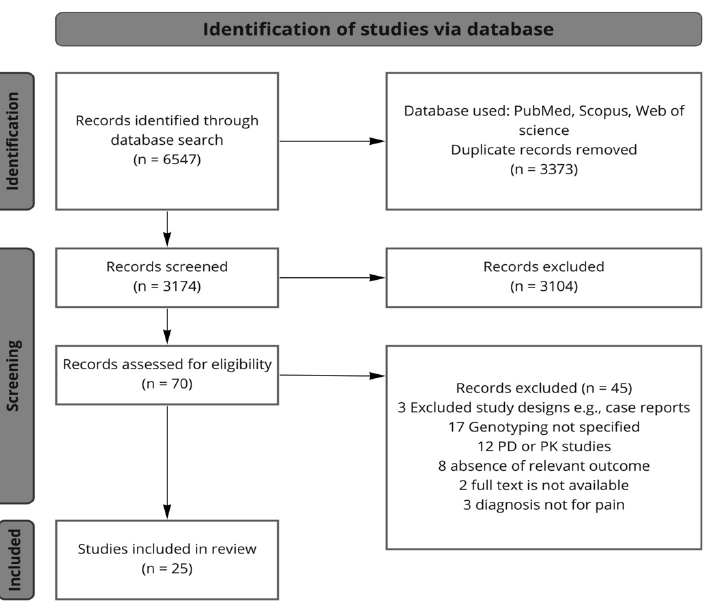
Figure 2. The study selection flow chart. PD = pharmacodynamic, PK = pharmacokinetic.